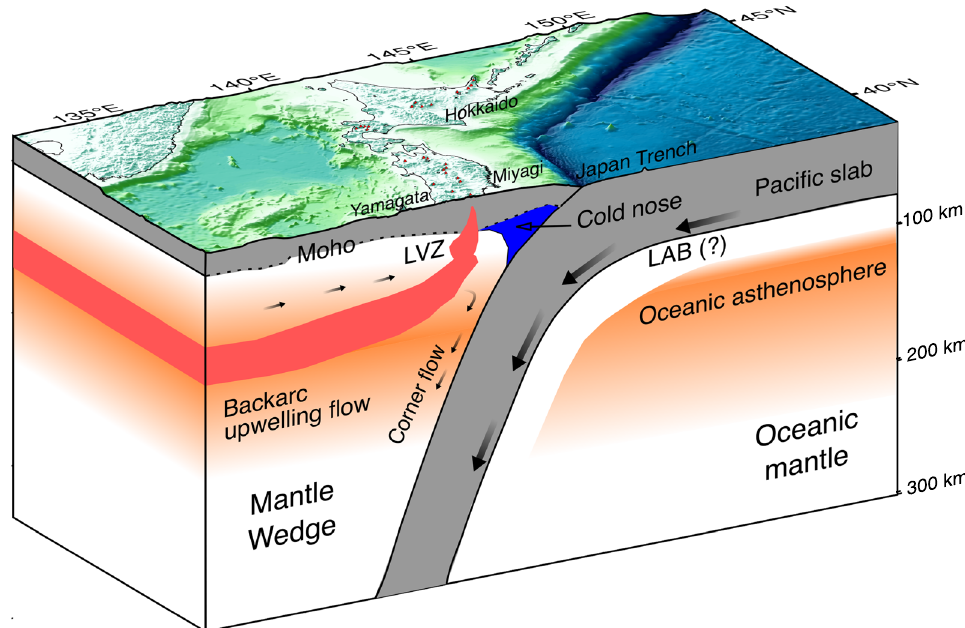
Fig. 1 Schematic diagram for heterogeneous rheology of NE Japan revealed by decade-long geodetic observation after the 2011 Tohoku-oki earthquake. The shape of upper surface of Pacific plate is adopted from Nakajima and Hasegawa (2006) and Nakajima et al. (2009). Qualitative colormap of viscosity marked blue for high viscosity and red for low viscosity. See main text for further